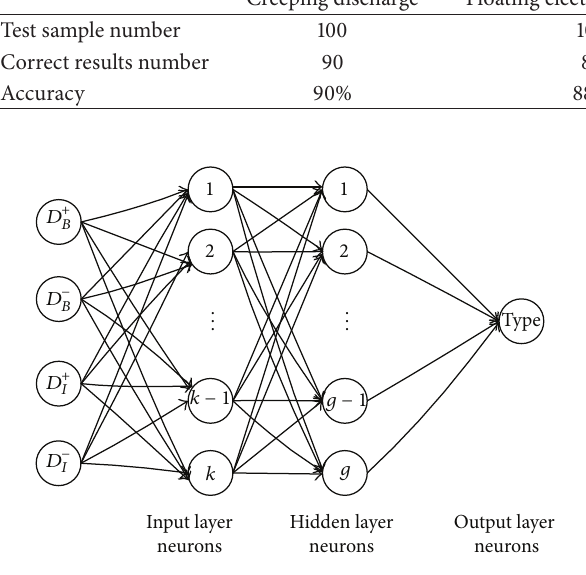
Figure 10: Structure of BP neural networks.